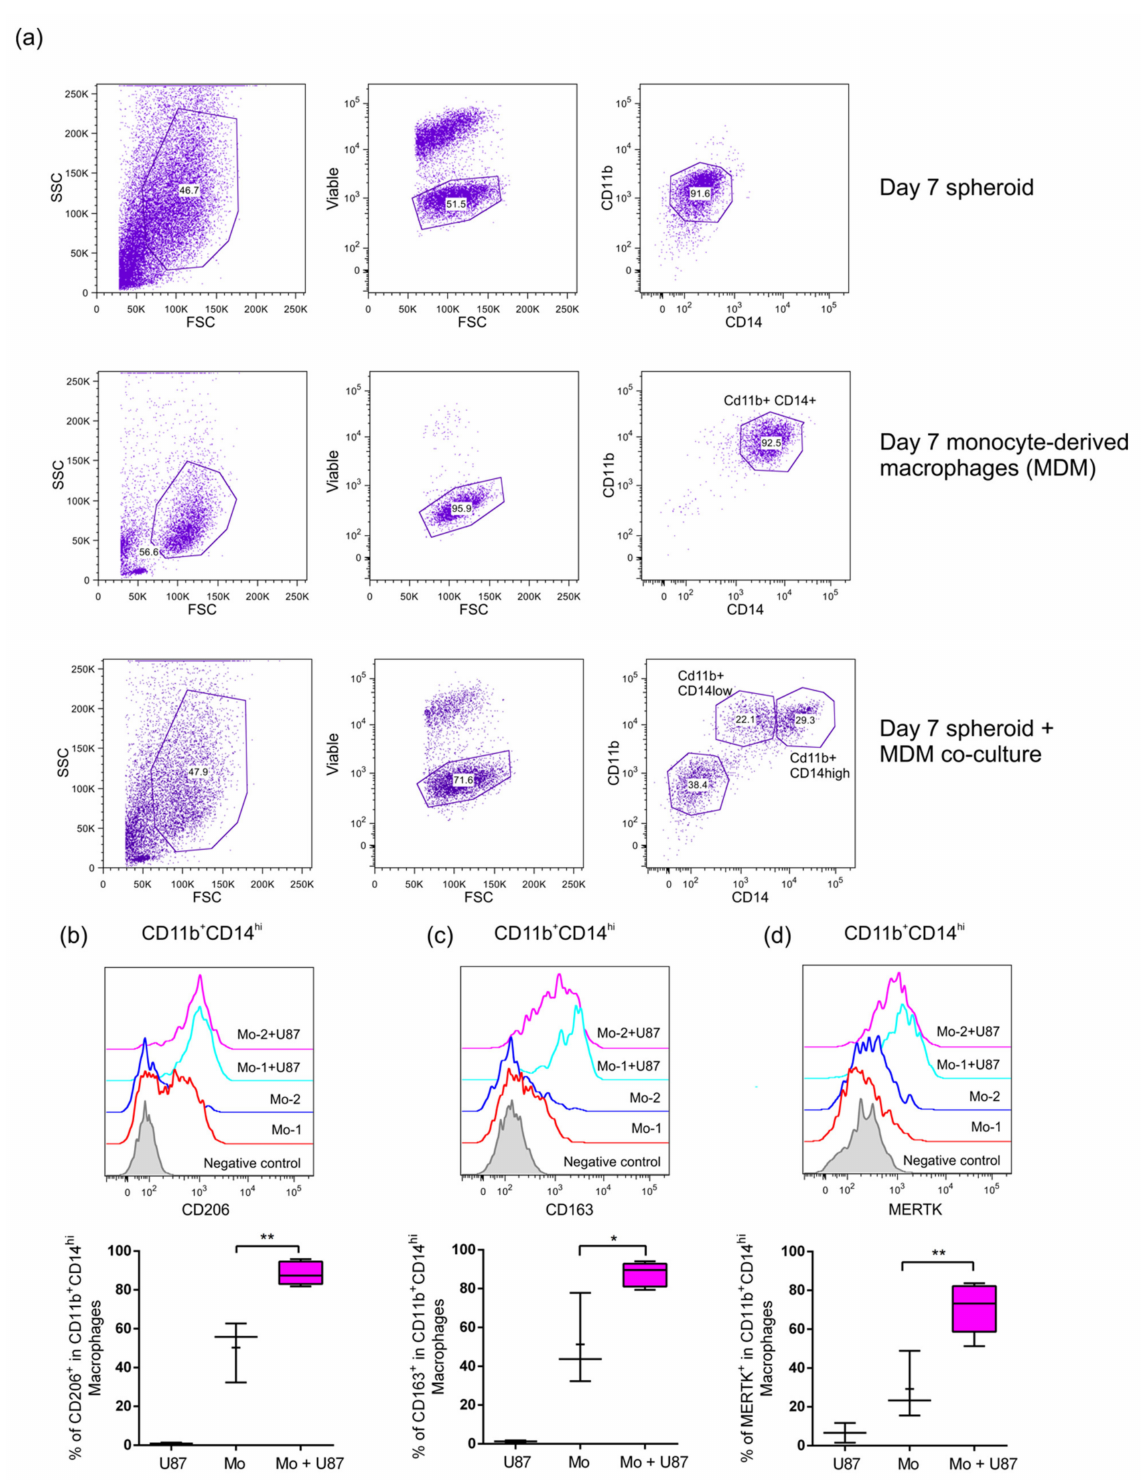
Figure 4. CD14 + monocytes infiltrating U87MG spheroid are skewed to a strong M2 phenotype. U87MG spheroids were co-cultured with sorted CD14 + human monocytes (Mo) for 7 days. Cells were dissociated and the phenotype of the infiltered monocyte-derived macrophages (MDM) was determined by flow cytometry. U87MG spheroids alone and 7-day MDM cultures were used as controls. ( a ) Gating strategies to discriminate CD11b + CD14 hi macrophages from the heterotypic co-cultures and control culture conditions are shown. ( b – d ) Representative plots as well as the independent data of each condition showing the percentage of CD206 + ( b ), CD163 + ( c ), and MERTK + ( d ) in the CD11b + CD14 hi gating. Two-tailed unpaired t -tests were performed *: p ≤ 0.05, **: p ≤ 0.01. n =